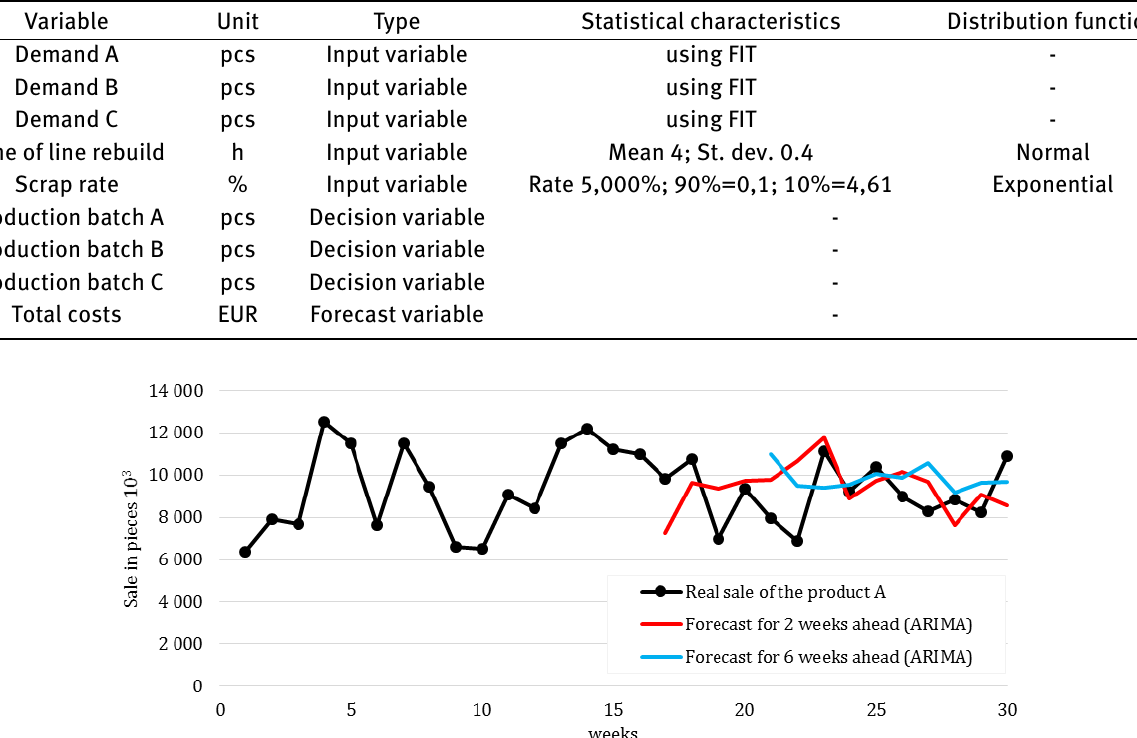
Figure 2: Real sale of the product A and forecasts by